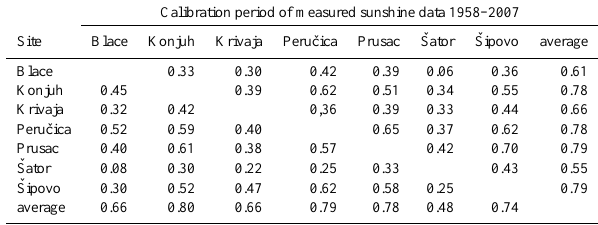
Table 2. Correlation values (Pearson’s r ) between the TRW series (individual site chronology and average, calculated as simple mean of all sites) over the calibration (upper triangle-period of measured sunshine data) and in the remainder of the common period (lower triangle-period before the measured sunshine data). No statistically significant differences were discovered between any of the pairs of correlation coefficients (z-test for two correlation